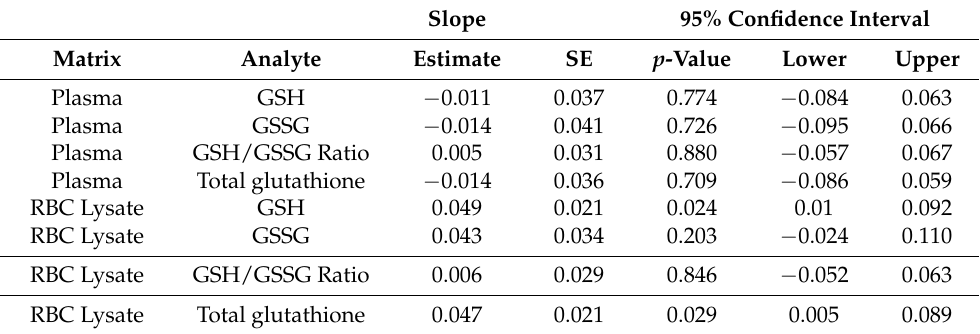
Table 5. Relationship between a-LA intake (in mg/kg body weight/day) and glutathione levels (in ng/mL) pooled over months 2, 4 and 6 in plasma and RBC Lysates.